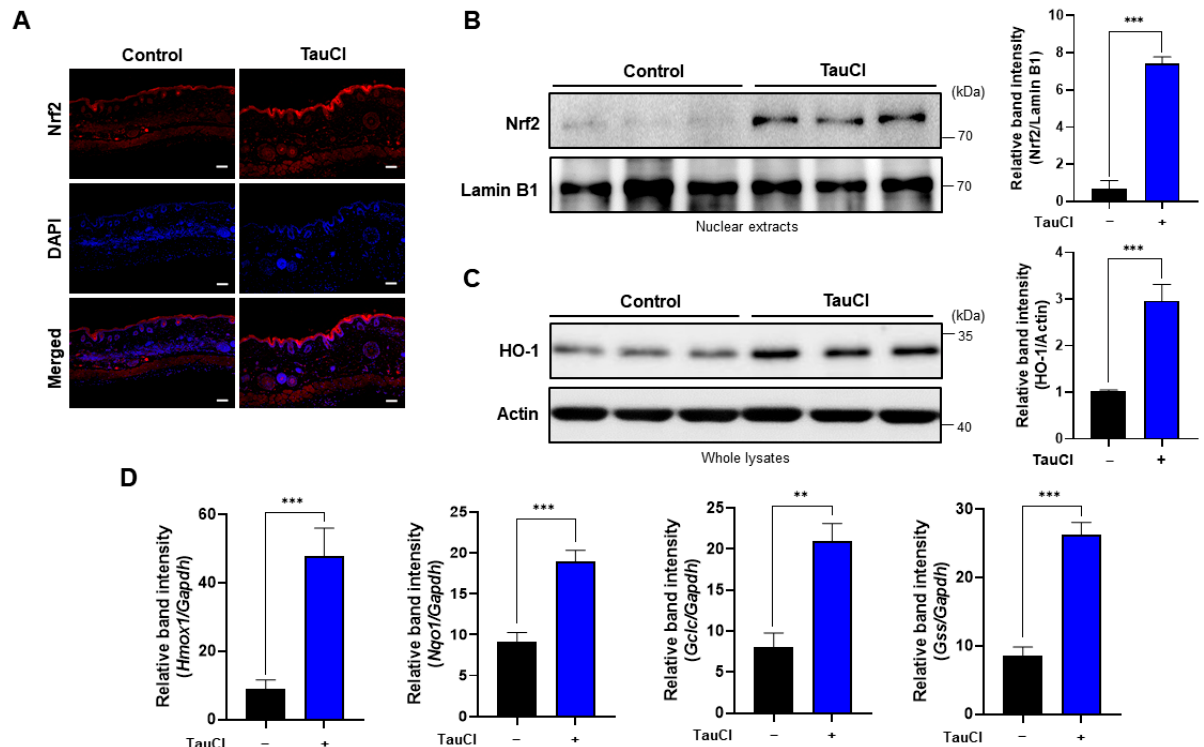
Figure 6. The Nrf2-mediated expression of antioxidant enzymes was elevated in TauCl-treated mice. ( A , B ) Nuclear localization of Nrf2 was assessed by immunofluorescence staining ( A ) and Western blot analysis ( B ). ( C ) The expression of HO-1 was determined by Western blot analysis. ( D ) Nrf2-mediated antioxidant gene expression was measured by qPCR. Results are expressed as means ± SD ( n = 3 for each group), analyzed by Student’s t -test. ** , *** Significantly different between groups compared (** p < 0.01; *** p < 0.001). Scale bar, 200 µ